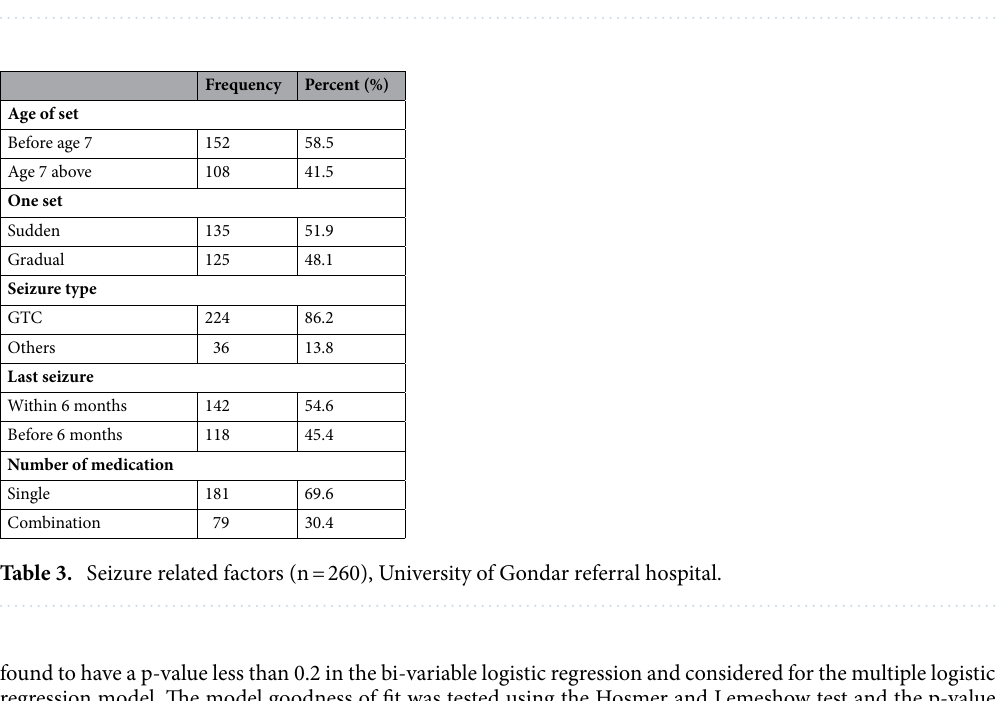
Table 2. Pregnancy, delivery and childhood related characteristics of participants (n = 260), University of Gondar referral hospital.